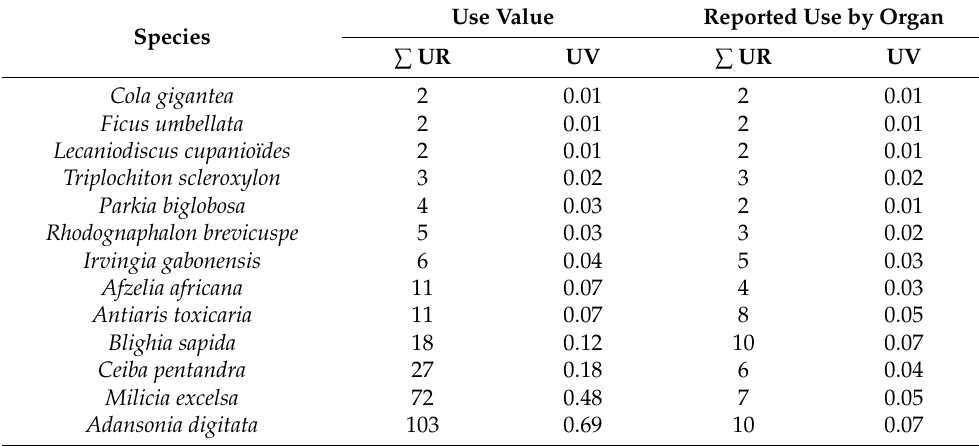
Table 6. Use value of